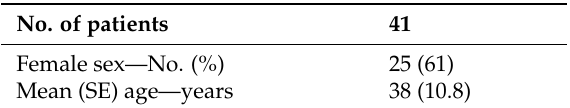
Table 2. Summary of multiple sclerosis (MS) patient demographics.